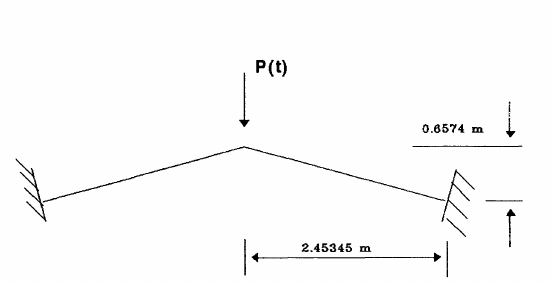
FIGURE 9 Plane frame under concentrated